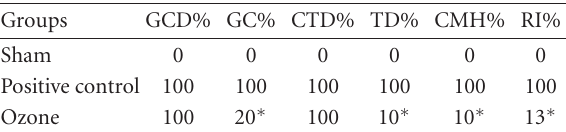
Table 2. Histological findings in the residual renal mass, due to the partial nephrectomy, in the di ff erent experimental groups, where GCD stands for glomerular capsule dilatation; GC glomerular collapse; CTD convoluted tubules dilatation; TD tubule degeneration; CMH cortical-medullar hemorrhages; and RI renal injury. ∗ denotes statistical significance of at least P < .